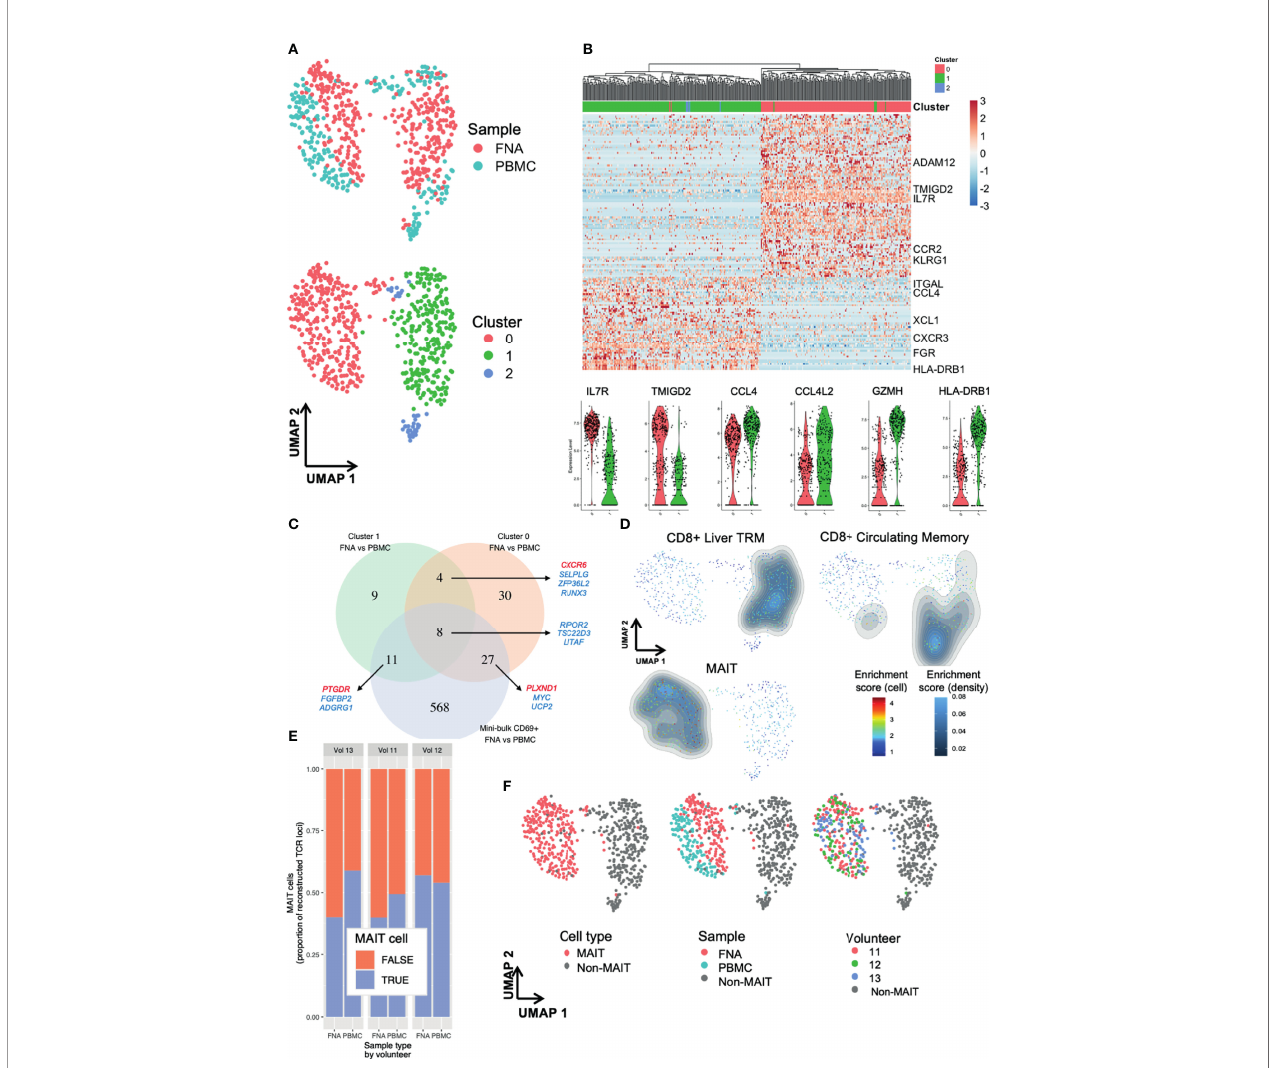
FIGURE 5 | Single-cell RNA-sequencing reveals subpopulations of liver TRM and blood TRM-like cells. Single cell differences between TRM and TRM-like cells depend on TRM cell cluster. (A) UMAP plots of 629 single cells. Plots according to sample type and Seurat cluster. Seurat FindClusters was run at 0.4 resolution. Each point represents one cell, either a PBMC or FNA live single CD20- CD3+ CD45+ CD8+ CD4- CD45RA- CD69+ lymphocyte FACS sorted and sequenced by the SmartSeq2 protocol. Six hundred and twenty-nine cells are presented in these plots. (B) Gene heatmap of the C1 TRM vs C0 TRM cell comparison. Cell gene count is centred and scaled across all row values. A sample of genes are shown, a full list of the 142 genes differentially expressed between C1 and C0 TRM cells is available in the source data fi le. All genes shown here were present in at least 50% of cells in each cluster, had |ln(FC)|>0.5 and an adjusted p value (Bonferroni correction)<0.05. The row hierarchical clustering dendrogram is based on Euclidean distances of cell gene count values considering all genes. Violin plots of gene expression of six selected genes are presented below. The violin colour corresponds to FNA cell cluster of origin, as seen in (A, C) Venn diagram of genes differentiating TRM and TRM-like cells. Venn diagram demonstrating the degree of convergence of cluster-level DGE and mini-bulk-level DGE. All included genes from single cell contrasts had a |ln(FC)|>0.25 and an adjusted p value (Bonferroni correction)<0.05 and the genes from mini-bulk contrasts had |log2(FC)|>1 and an FDR < 0.05. DGE, differential gene expression. The mini-bulk contrast refers to that which is presented in Figures 3 , 4 . A sample of the genes that are shared among the datasets is illustrated; blue indicates the gene is down-regulated in FNA CD69+ cells and red indicates the gene is up-regulated in FNA CD69+ cells, compared to blood CD69+ cells. (D) UMAP plots with signature enrichment scores. The enrichment of three signatures was assessed for each of the 629 cells and visualised in the UMAP by Single-Cell Signature Explorer (44). The per-cell signature enrichment was plotted, and density distribution of scores was overlaid. The signature scores represent a qualitative measure for visualisation. The signatures were obtained from Zhao et al. (22). (E) Proportion of recombinants that were derived from MAIT cells. MAIT cells were de fi ned based on TCR a locus: any cell that expressed TRAV1-2 paired with TRAJ33, TRAJ12 or TRAJ20 was de fi ned as a MAIT cell, regardless of the TCR b locus recombinant, if present. Any recombinant derived from a MAIT cell was labelled as such and excluded from non-MAIT cell analyses. (F) UMAP of 629 single cells with plots according to cluster, MAIT cell TCR, sample type and volunteer. In all plots, grey points ( “ non-MAIT ” ) represent cells that were either not classi fi ed as MAIT cells or cells for which TCR reconstruction could not be performed. Seurat FindClusters was run at 0.4 resolution, using a shared nearest neighbour clustering method. C, cluster; DGE, differential gene expression; FACS, fl uorescence-assisted cell sorting; FDR, false discovery rate; FNA, fi ne needle aspirate; PBMC, peripheral blood mononuclear cells; MAIT, mucosal-associated invariant T cell; TRM, tissue-resident memory T cell; UMAP, uniform manifold approximation and